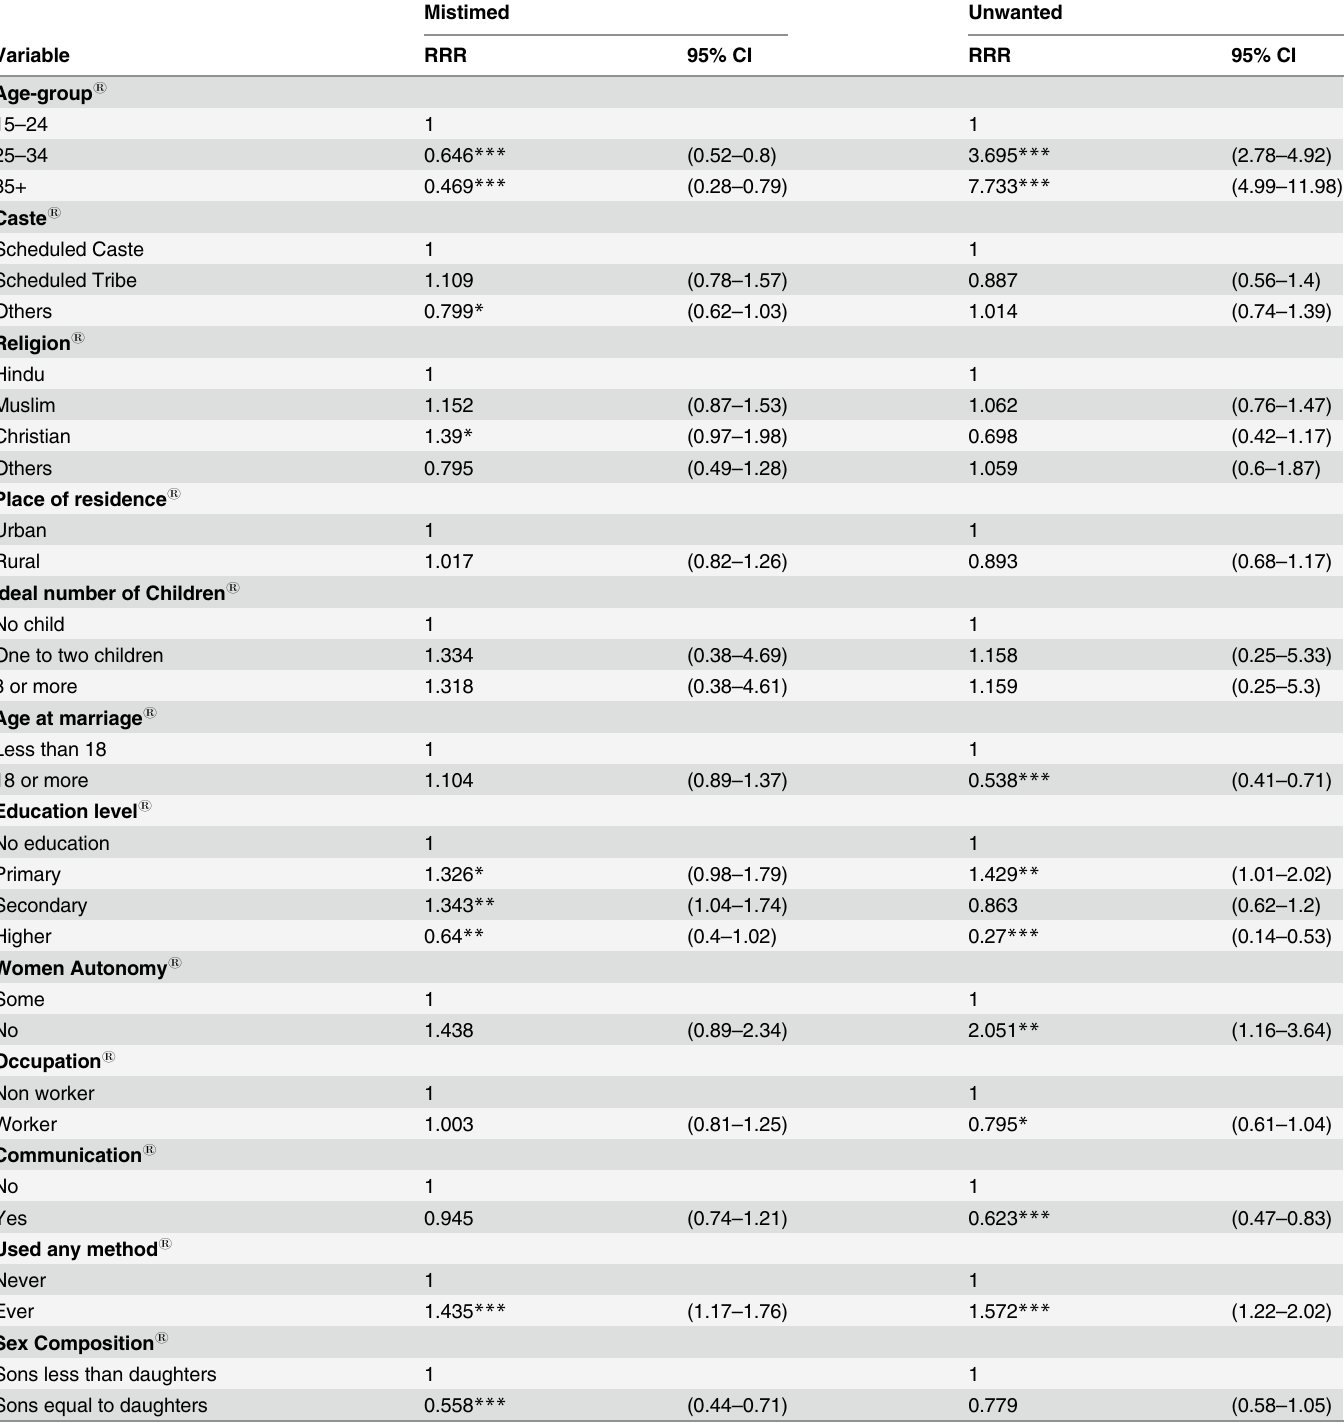
Table 2. Multinomial logistic regression of factors associated with mistimed and unwanted pregnancies among currently pregnant ever married women in